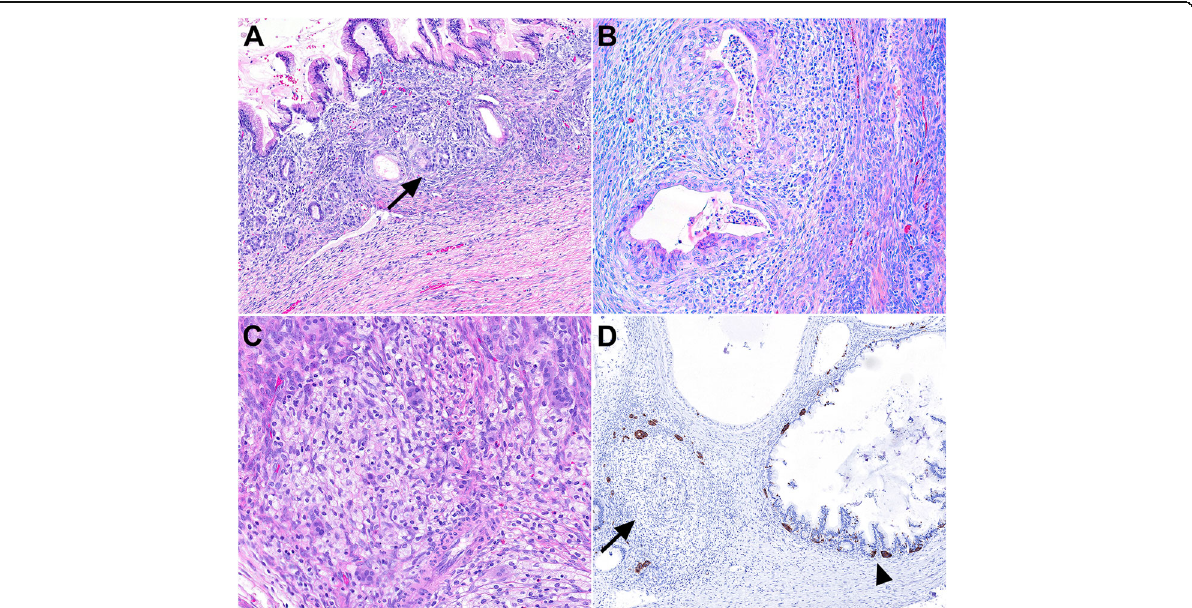
Round to ovoid shaped histiocytic infiltrates with endocrine cell micronests at the periphery, representing the late-stage glandular degeneration with preserved endocrine cells. D. Synaptophysin immunostaining highlights stromal endocrine cell micronests and intraepithelial